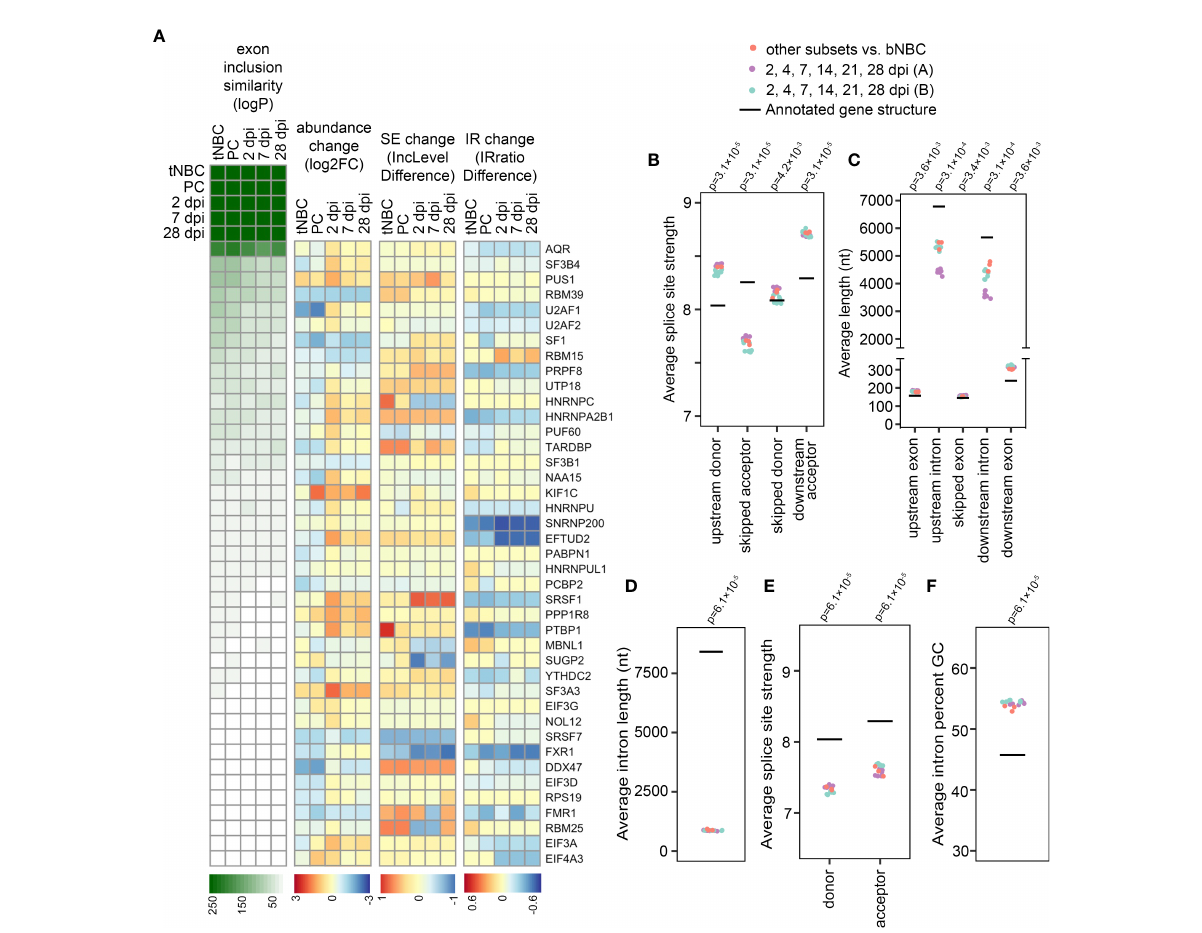
FIGURE 3 Increased splicing program ef fi ciency alters the splicing pro fi le. (A) Heatmaps indicating exon inclusion similarity (logP = -log(p-value) by hypergeometric test), mRNA abundance change (log2FC = log 2 (fold change) by sleuth), skipped exon (SE) change (IncLevelDifference = inclusion level difference by rMATS), and intron retention (IR) change (IRratio difference = intron retention difference by IRFinder) for RBPs with exon inclusion changes most similar to those of B cell differentiation/EBV infection. For RBP genes with multiple splice junctions the SE and IR events with the highest absolute inclusion/retention difference measurable in all compared replicates are displayed. PC = PCs compared to blood NBCs; tNBC = lymphoid (tonsil) NBCs compared to blood NBCs; 2, 7 and 28 dpi = EBV-infected cells at speci fi ed timepoints compared to uninfected cells in Blood timecourse (A, B) Average splice site strength calculated by MaxEntScan for exons showing increased inclusion in differentiating or EBV-infected B cells (FDR < 0.05 by rMATS). (C) Average length in nucleotides (nt) of exons showing increased inclusion in differentiating or EBV-infected B cells (FDR < 0.05 by rMATS), and their fl anking introns and exons. P-values compared to annotated averages calculated by Wilcoxon signed rank exact test with Bonferroni correction. (D) Average length in nucleotides (nt) of introns showing decreased retention in differentiating or EBV-infected B cells (FDR < 0.05 by rMATS). (E) Average splice site strength calculated by MaxEntScan for introns showing decreased retention in differentiating or EBV-infected B cells (FDR < 0.05 by rMATS). (F) Average GC content of introns